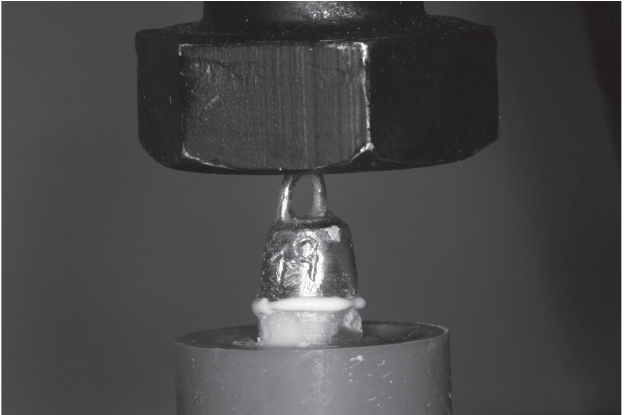
Fig. 4 - Standardization of luting load.